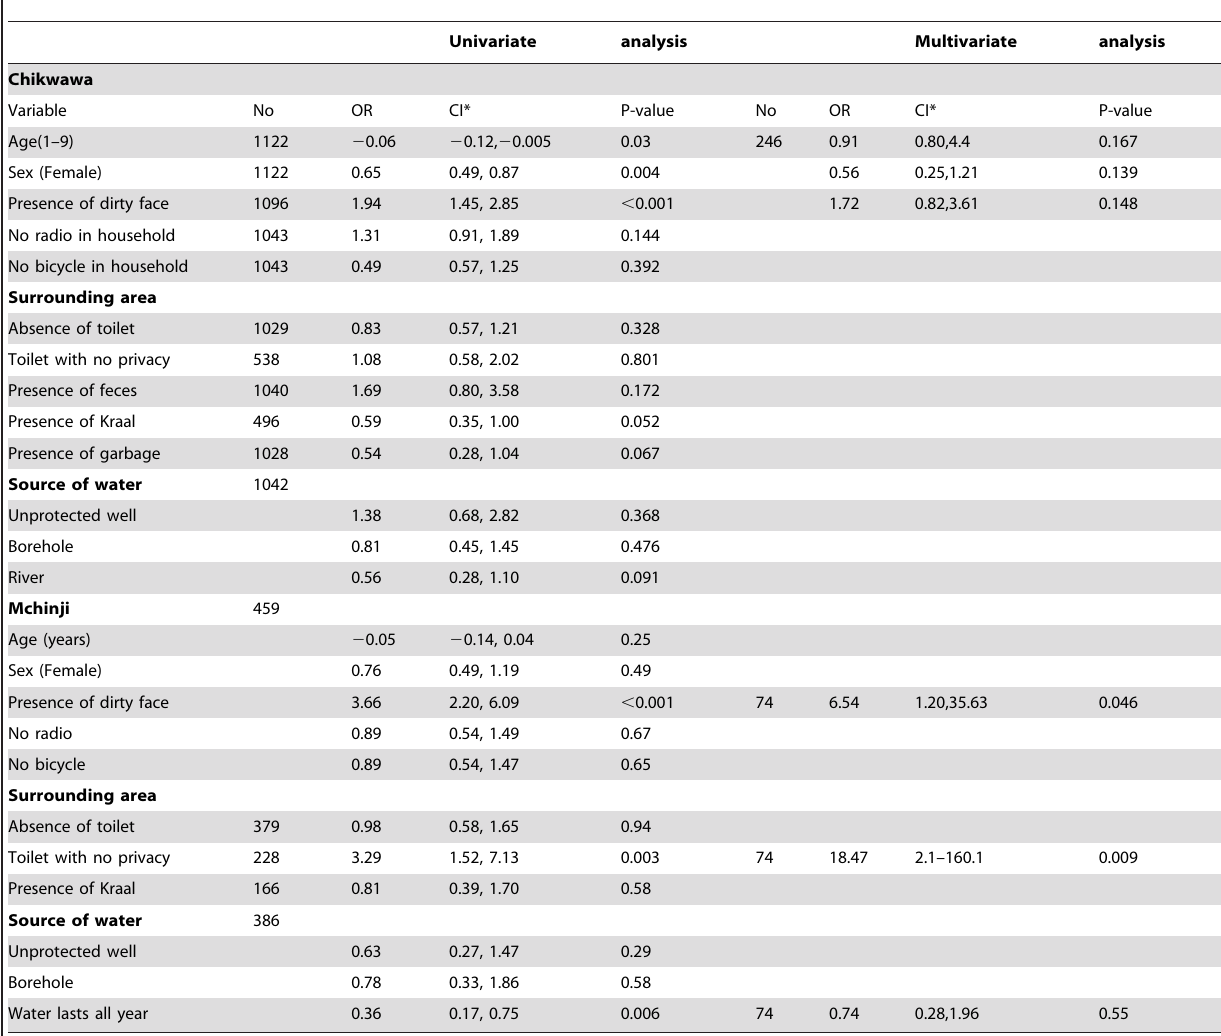
Table 6. Risk factors for Trachoma follicular (TF) obtained through univariate and multivariate logistical